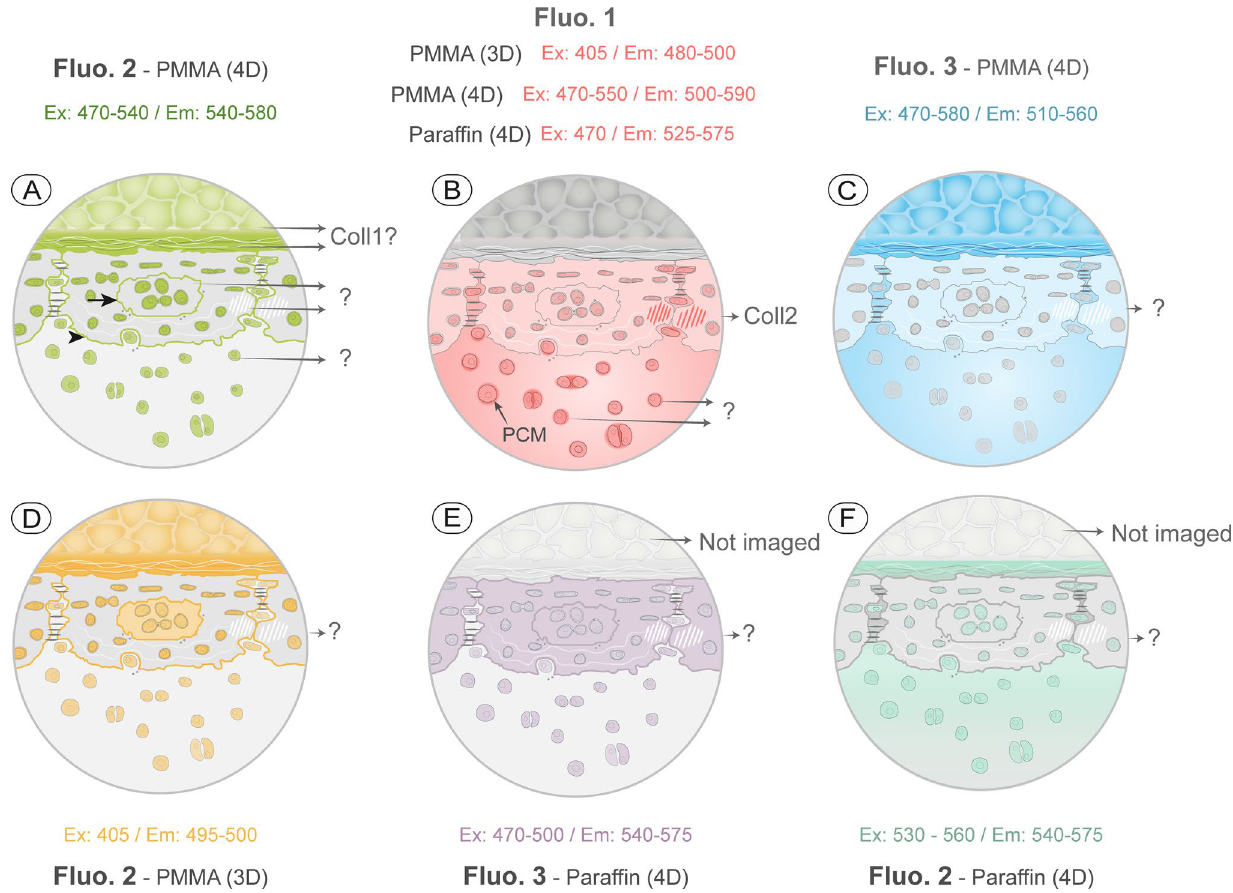
Fig. 12 Summary of the tessellated cartilage fluorescence signatures localized in this study, classified according to EEM, tissue location, and potential source. Each fluorescence signature’s tissue associations are summarized visually in a color-coded tesserae schematic (see Fig. 1). Fluorescence signatures are listed according to assigned numbers from Table 2, their sample preparation, and imaging modality (e.g. Fluo. 2, PMMA, 4D) and excitation (Ex) and emission (Em) values listed are the peak wavelengths associated with the strongest signal for that fluorescence signature. A Fluorescence signatures associated potentially with Coll1 (in perichondrium and muscle). In contrast, the AF source associated with the border of the tesserae center (arrow), peripheral regions, the outer tesseral border (arrowhead) and the cells are unknown. B Several fluorescence signatures likely related with Coll2, based on comparisons with immunostaining. The source of the AF in the pericellular matrix (PCM; Fluo. 1, PMMA, 4D) is unknown (in mammal cartilage, the PCM is comprised of collagen type VI). C Unknown fluorescence signatures distributed in muscle, perichondrium tesserae and matrix of joints and unmineralized cartilage, but absent in cells. D Unknown fluorescence signatures observed in muscle, perichondrium, center-periphery border, and the outer margin of tesserae (arrow and arrowhead in A ), and within cells. E The source of this fluorescence signature is unknown, found in tesserae and cells. F Unknown fluo- rescence signature in tesserae and all cells. Pericellular matrix (PCM), Collagen type I (Coll1), Collagen type II